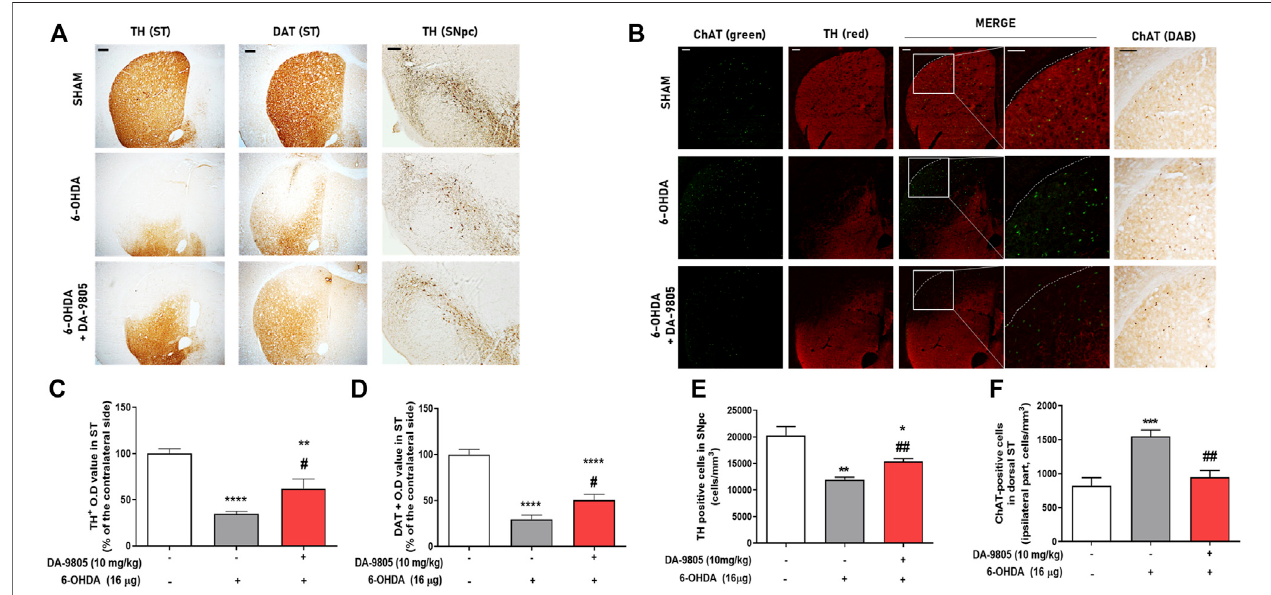
FIGURE 3 | Effect of DA-9805 on enzymes for dopamine-acetylcholine homeostasis in 6-hydroxydopamine (6-OHDA)-lesioned mouse dorsal striatum (ST) and substantia nigra pars compacta (SNpc). Representative photographs of tyrosine hydroxylase (TH) and dopamine transporter (DAT) staining (A) , dual label fl uorescence ofCholinetransferase(ChAT)andTH (B) .GraphswererepresentedasopticaldensityvalueofTHorDAT-positive fi bers (C,D) inthedorsalST,thenumberofTHpositive cells (E) in the SNpc and the number of ChAT positive cells (F) in the dorsal ST. Scale bar = 100 μ m. Values are given as the mean ± S.E.M. (C – F) Data were analyzed by One-way ANOVA followed by post hoc Bonferroni ’ s multiple comparisons test. ** p < 0.01 and **** p < 0.0001; compared to the sham group. # p < 0.05; compared to the 6-OHDA group. N = 6 per group.